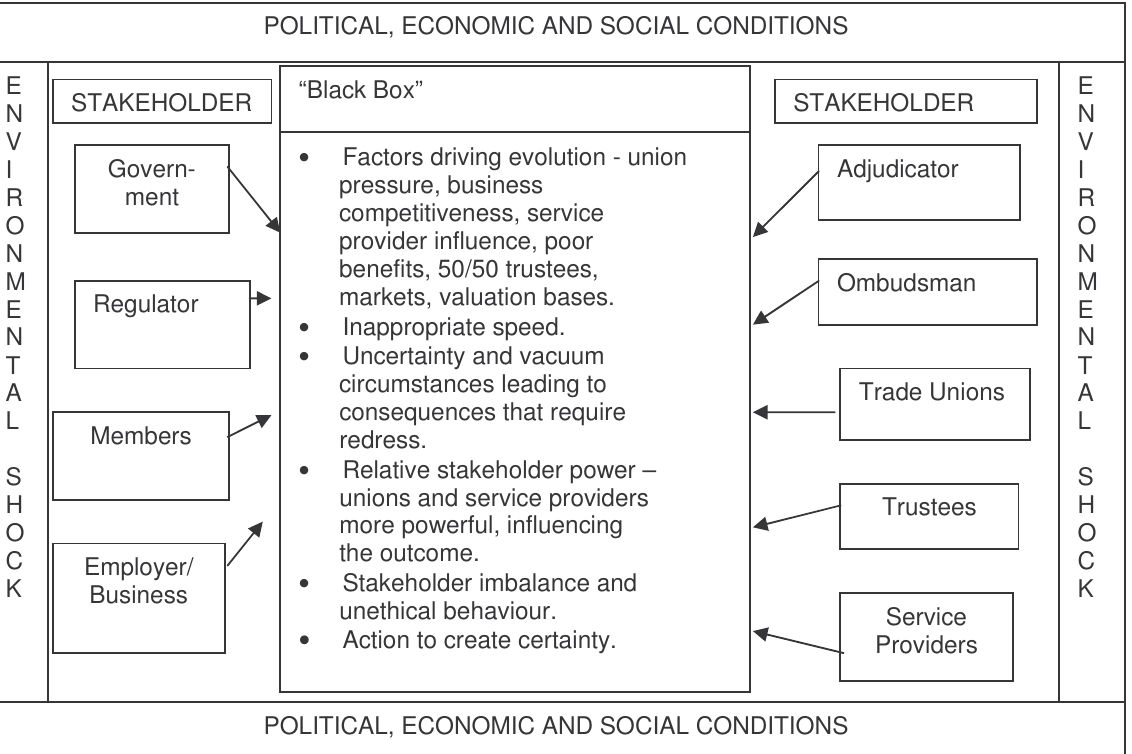
Figure 1: Graphical representation of the model for dealing with environmental